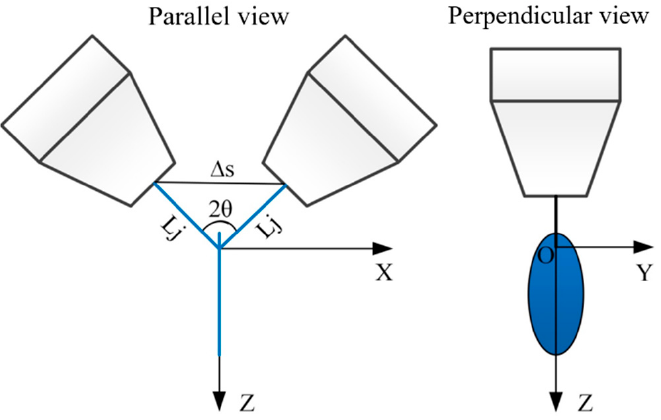
Figure 1. Schematic diagram of the collision of two jets.